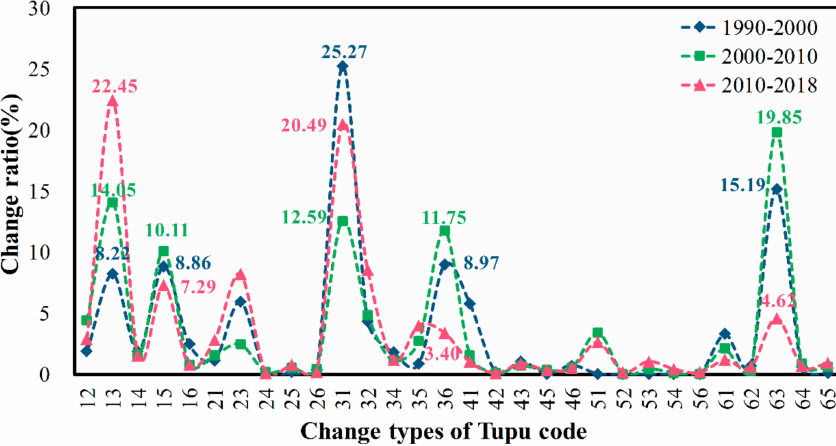
Figure 5. Change ratio of Tupu units from 1990 to 2018 in the YRB. (Note: No. 1–6 has the same meaning as Figure 3. The Tupu units’ codes can be seen in Table